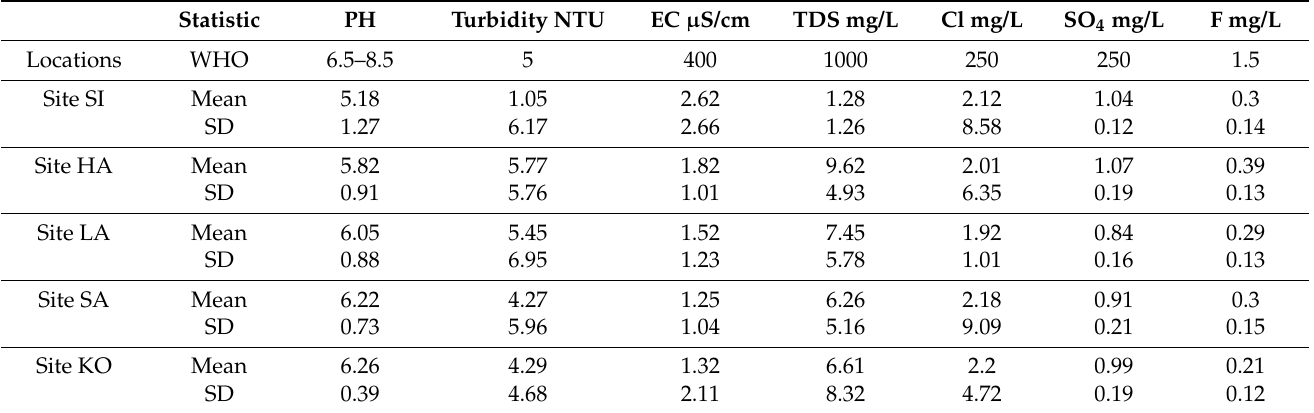
Table 1. Physicochemical parameters of roof-harvested